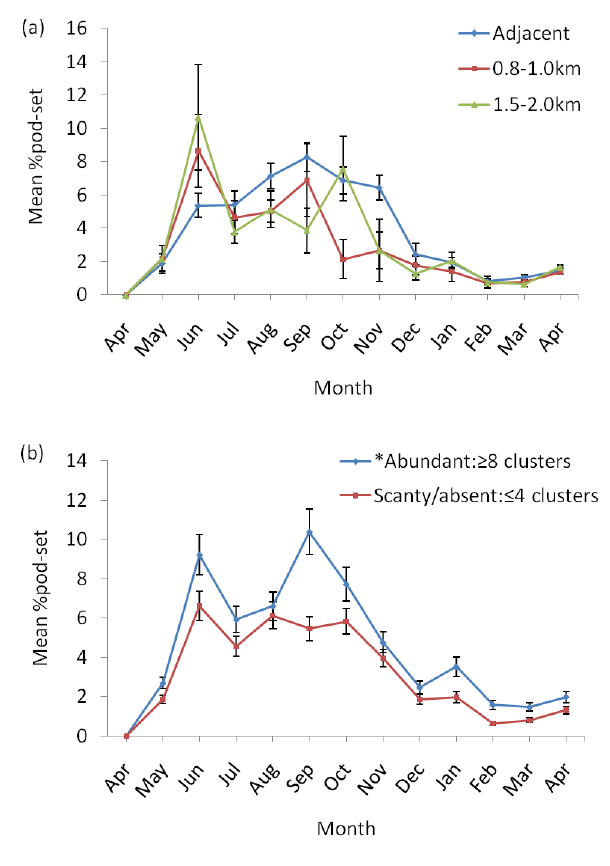
F IG . 4. Monthly dynamics of cocoa pod-set under: (a) Varying farm distance from natural forest. (b) Availability of plantain/banana [*see figs. 1c &